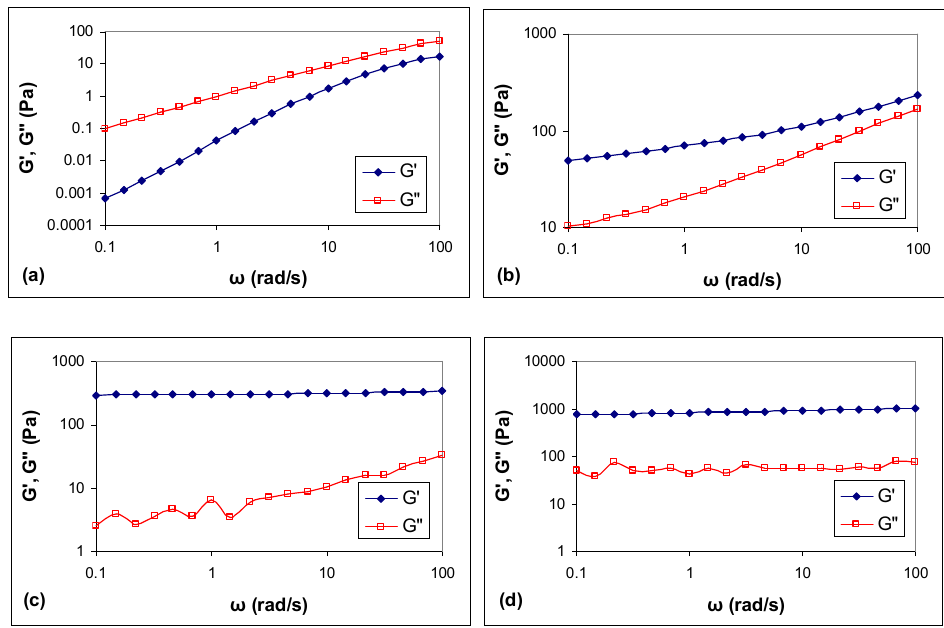
Figure 2. Storage modulus, G’, and loss modulus, G”, of different samples as function of frequency after one day at 37 °C. ( a ) Hydroxypropylmethylcellulose (HPMC); ( b ) HPMC/XLS; ( c ) Si-HPMC; ( d ) Si-HPMC/XLS. The content of XLS in composite hydrogels, which were prepared using B, were 1 wt %.